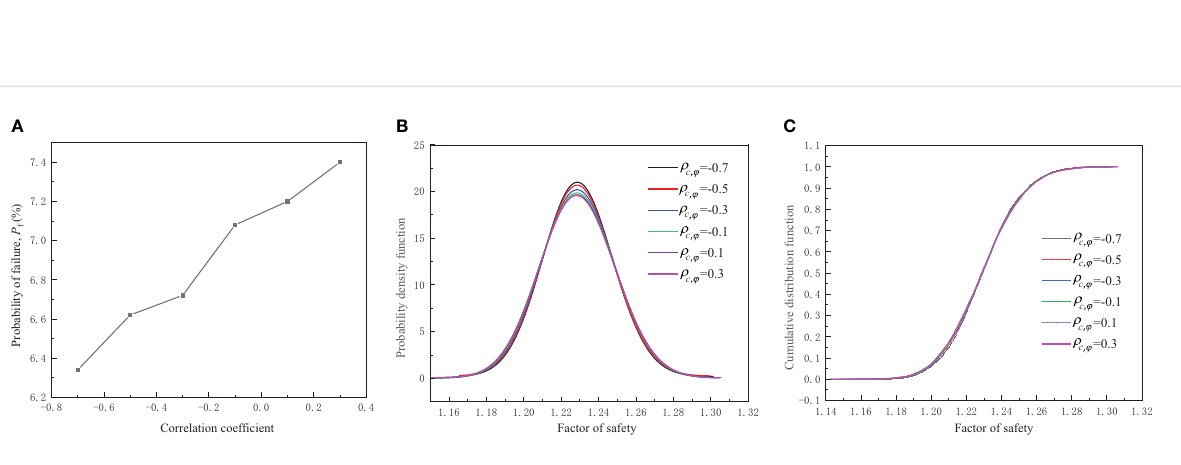
FIGURE 11 The effect of the correlation coef fi cient: (A) In fl uence of different correlation coef fi cients on failure probability; (B) probability density function; (C) probability distribution of the FOS.